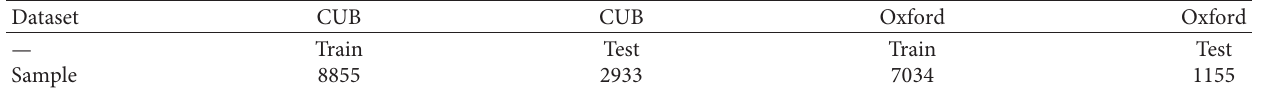
Table 1: Datasets of experiment.